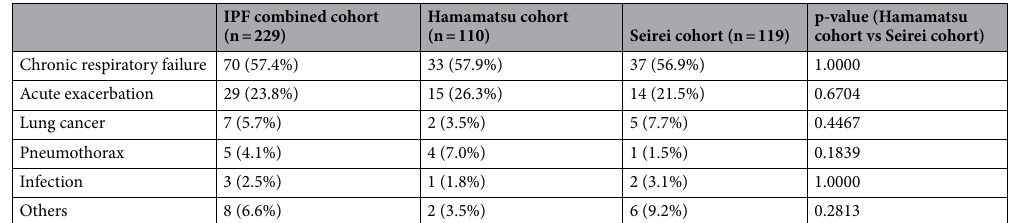
Table 3. Cause of mortality in patients with IPF treated with antifibrotic therapy.